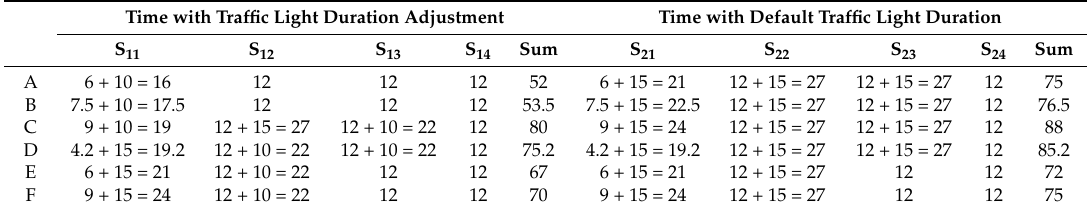
Table 4. Time the vehicles take to move through the different road segments. Time with Traffic Light Duration